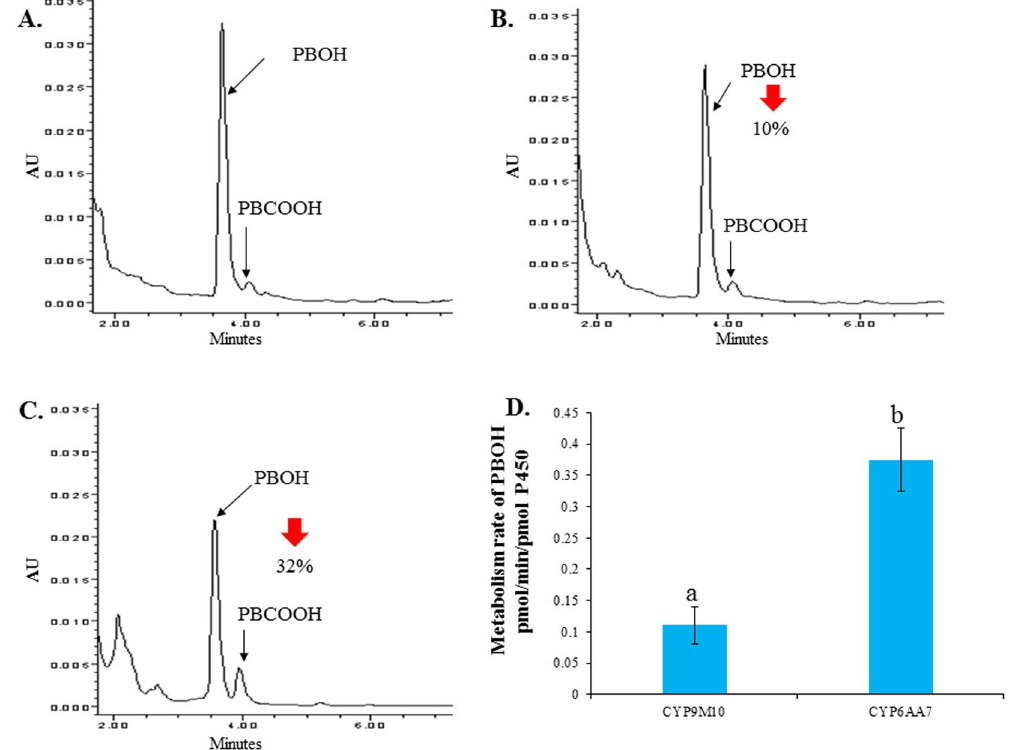
Figure 5. Metabolism profile of PBOH by CYP6AA7/CPR or CYP9M10/CPR microsomes. ( A ) Control: PBOH (20 µ M) incubated with CYP9M10/CPR or CYP6AA7/CPR microsomes (100 pmol P450 in 0.1 M Tris pH = 7.5) for 2 h at 30 °C without NADPH. The black arrows indicate the peaks for PBOH and its metabolite PBCOOH; ( B ) PBOH metabolized by microsomes of CYP9M10/CPR expressing Sf9 cells with NADPH; ( C ) PBOH metabolized by microsomes of CYP6AA7/CPR expressing Sf9 cells with NADPH; D. Metabolism rate of PBOH in different CYP/CPR microsomes. The results are shown as the mean ± S.E (n ≥ 3). Statistical significance is represented by P ≤ 0.05 using one-way